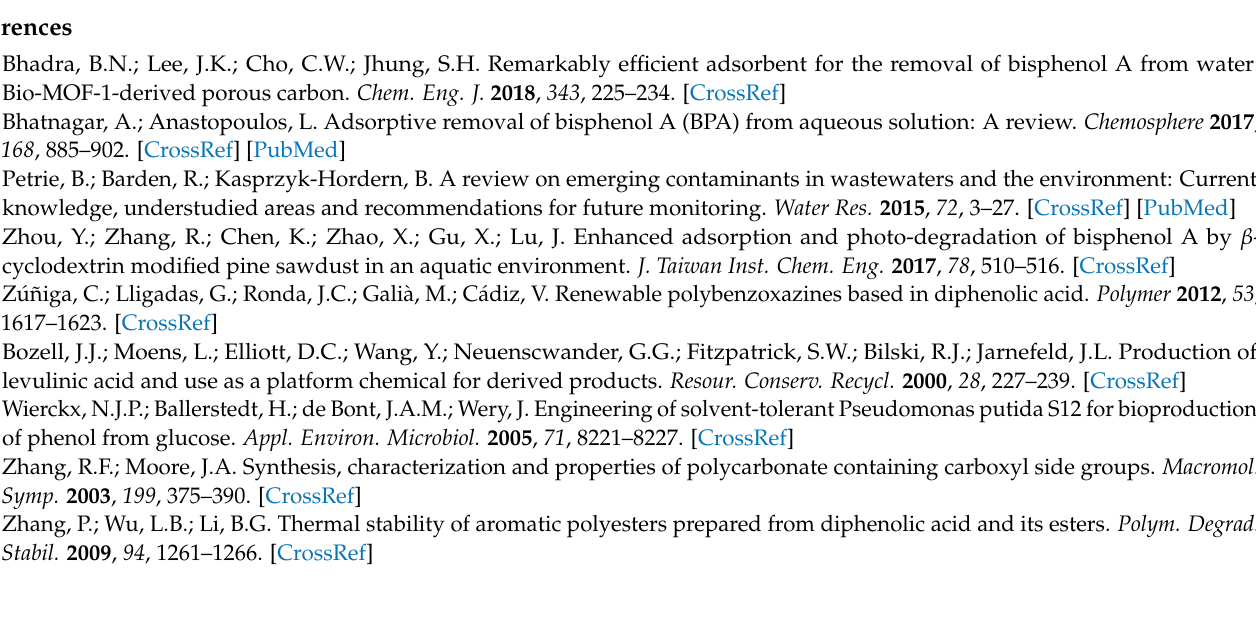
Figure S2: Standard curve of DPA; Figure S3: FT-IR spectra of DA/ β -CD after adsorption of DPA; Figure S4: (a) UV-vis absorption spectrum of DPA after adsorbed by DA and DA/ β -CD, (b) adsorp- tion rates of DPA (10 ppm). 0.2 g adsorbent in 50 mL of DPA solution (10 ppm) at room temperature; Table S1: List of relevant abbreviations in the literature; Table S2: Comparison of Existing DPA Removal